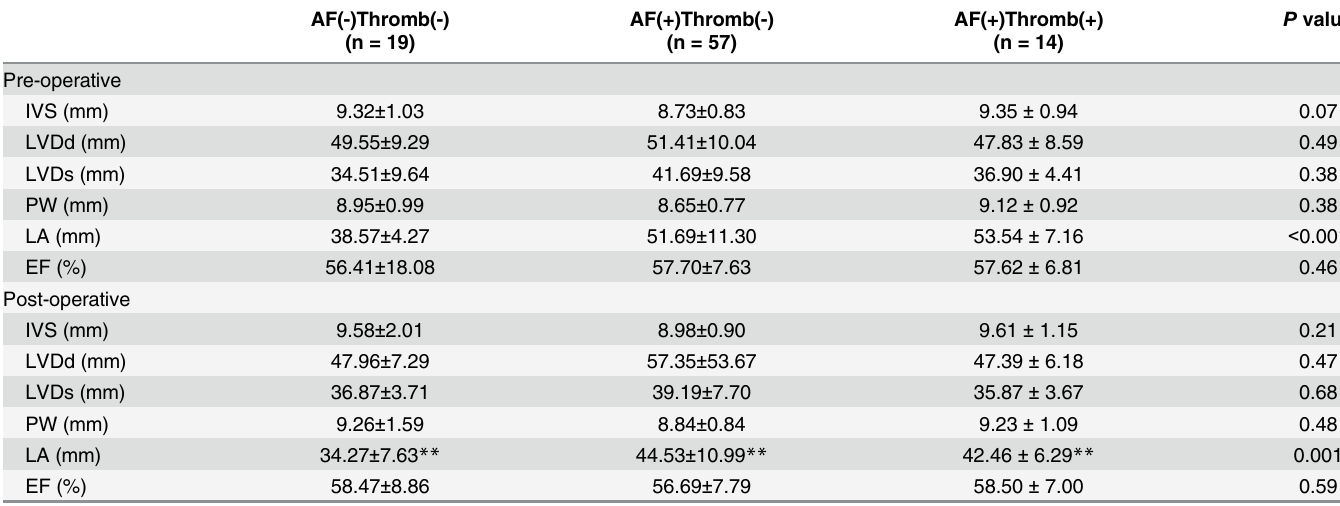
Table 2. Echocardiography parameters.